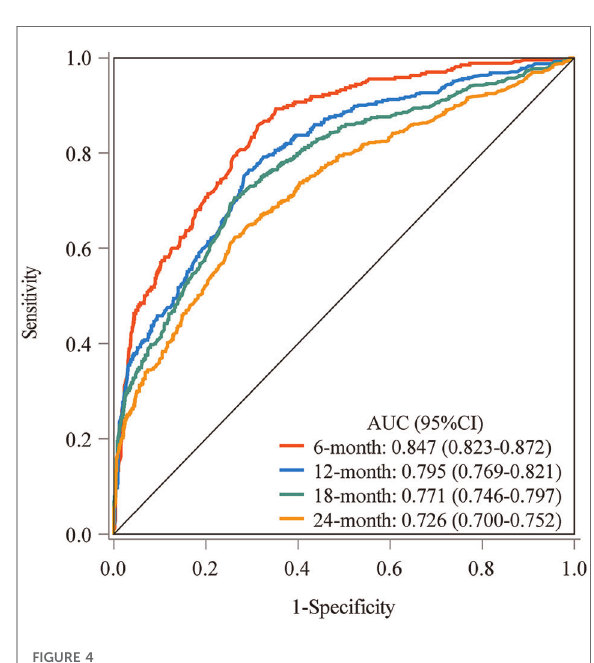
( Figure 4 ). The calibration curves of the prediction model for predicting the 6-month mortality ( Figure 5A ), 1-year